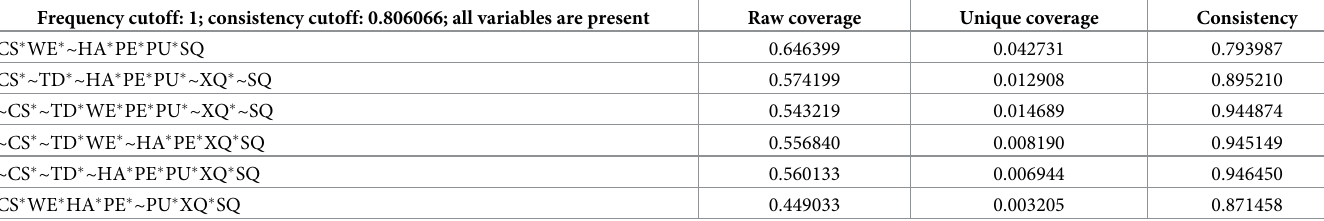
of users’ actual behavior. According to Si, et al. [59], sustainable usage intention of shared bike positively affects users’ sustainable usage behavior ( β = 0.334, t = 9.001). This study provides usage. Table 8. Intermediate